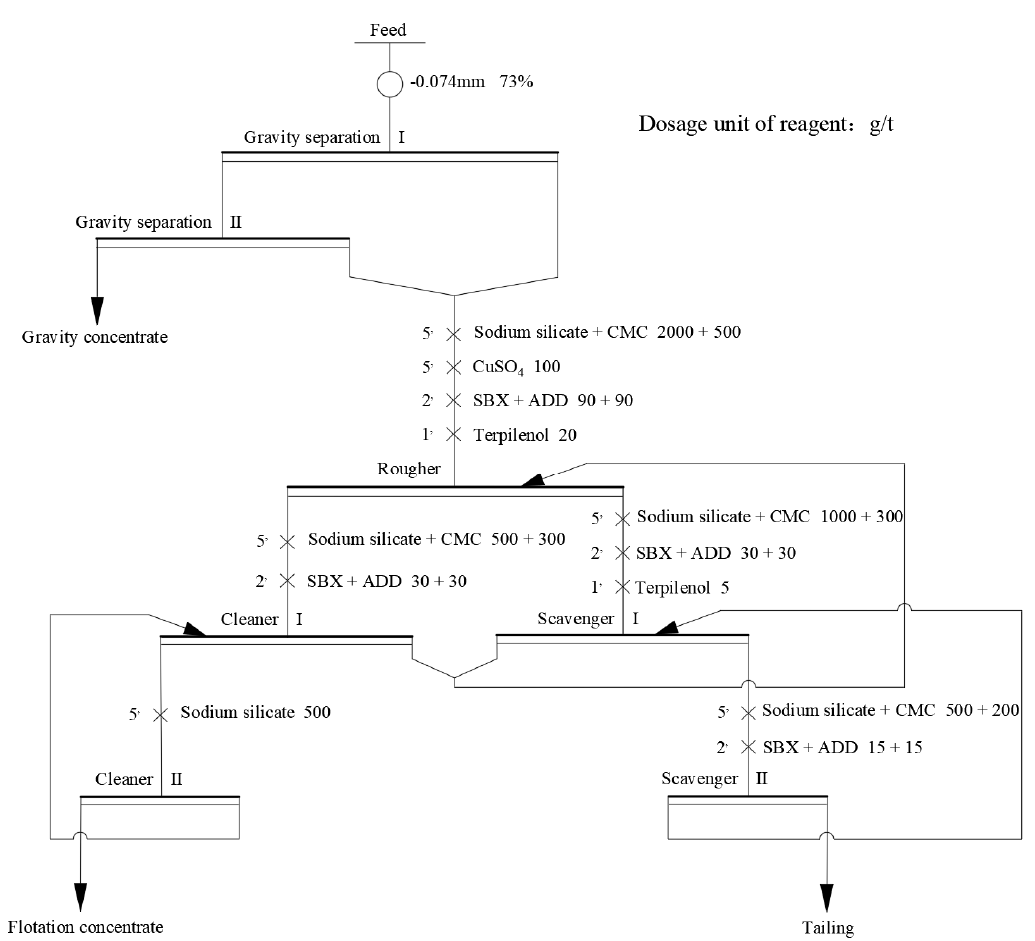
Figure 12. Image of closed-circuit combination process of gravity separation and flotation. Table 5. The results of the closed-circuit test.